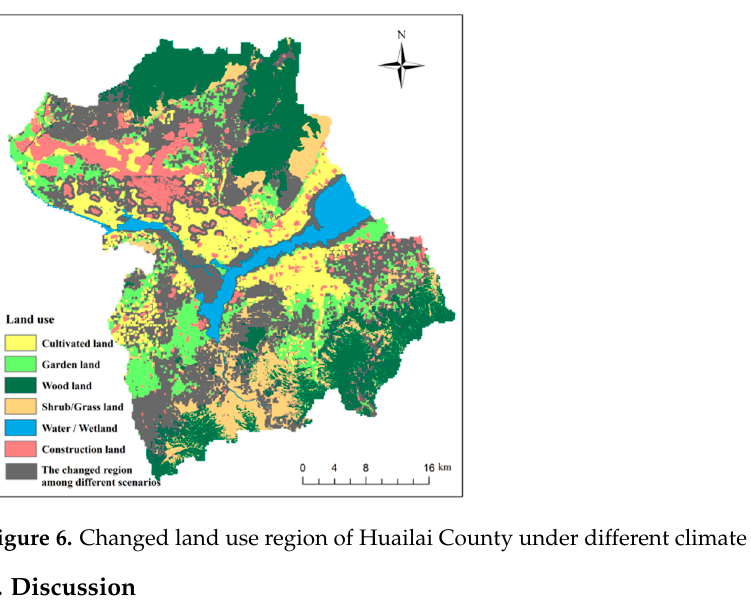
Figure 5. Land use optimization map of Huailai County under future climate change scenarios.